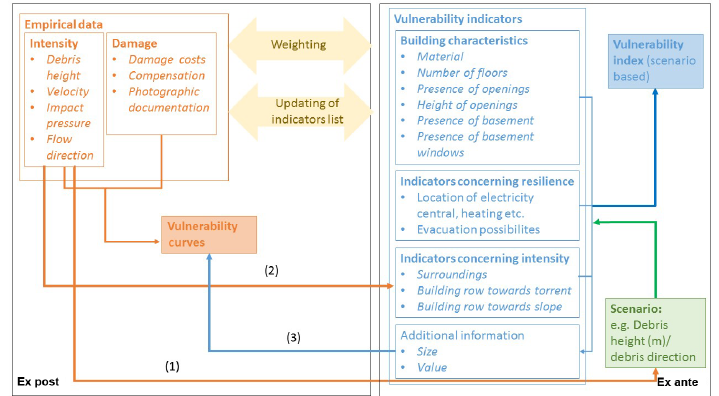
Figure 10. A preliminary framework for the assessment of physical vulnerability (adapted for debris flow hazards) showing clearly the need for exchange and interaction between the two methodological approaches. Table 4. Indicators for a scenario of 1.5m debris height intensity and flow coming from the slope and not the river